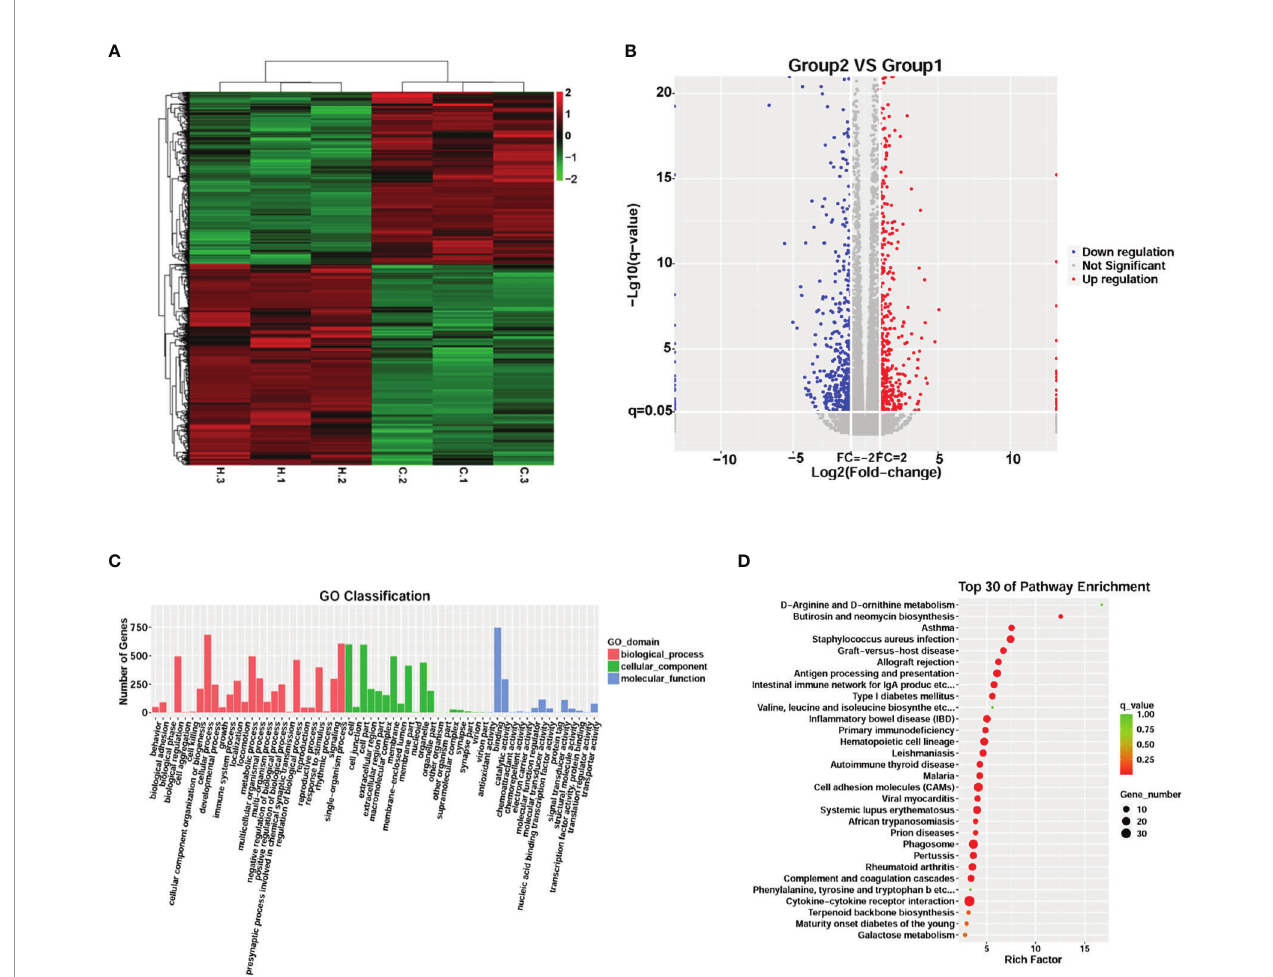
FIGURE 2 | Transcriptome analysis comparing G. parasuis -infected porcine brain vs. control porcine brain. (A) Hierarchical clustering heatmap of transcript abundance from RNA-seq. Each row represents a transcript, H.1, H.2, H.3 represent G. parasuis -infected porcine brain, and C.1, C.2, C.3 represent negative controls. (B) Volcano plot showing differentially expressed genes. The vertical axis shows the -log10 (q-value), and the horizontal axis shows log2 (Fold-change). (C) GO functional category analysis of differentially expressed genes. The vertical axis shows the number of genes in each term, and the horizontal axis shows biological process, cellular component, and molecular function terms. (D) KEGG pathway enrichment of differentially expressed genes. Top 30 KEGG pathways are shown in the vertical axis and the horizontal axis shows the rich